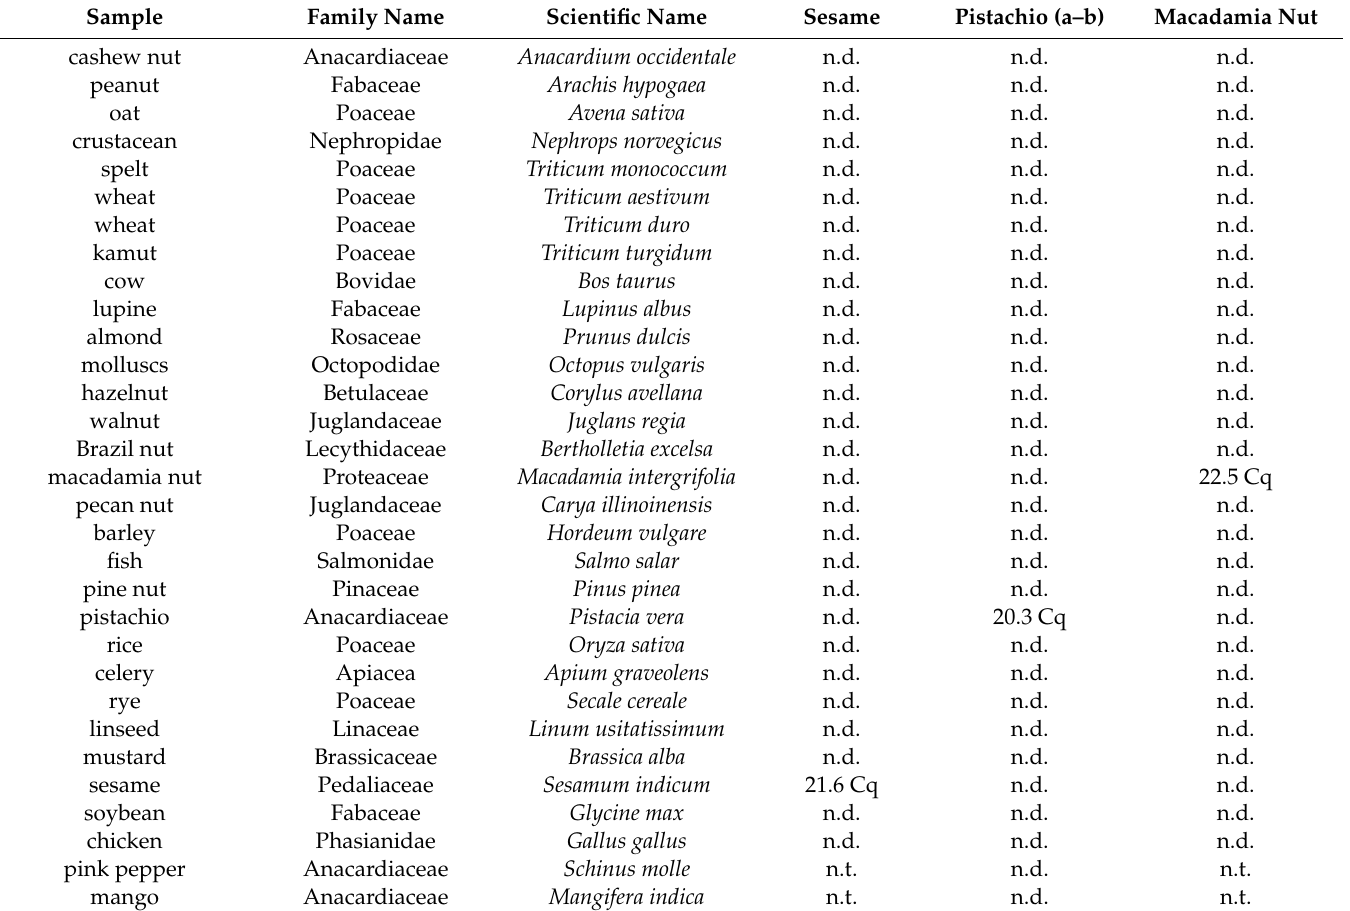
Table 3. Exclusivity and inclusivity panel and specificity test